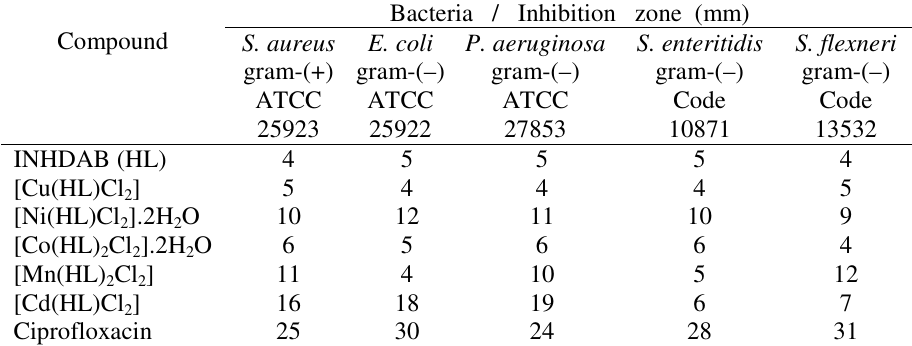
Table 5. Antimicrobial activity of INHDAB and its metal